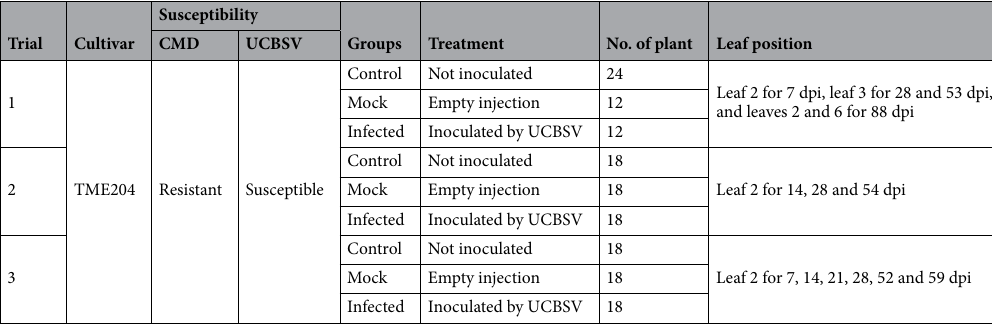
Table 1. Experimental design of the Cassava-TME204-UCBSV A-MSI